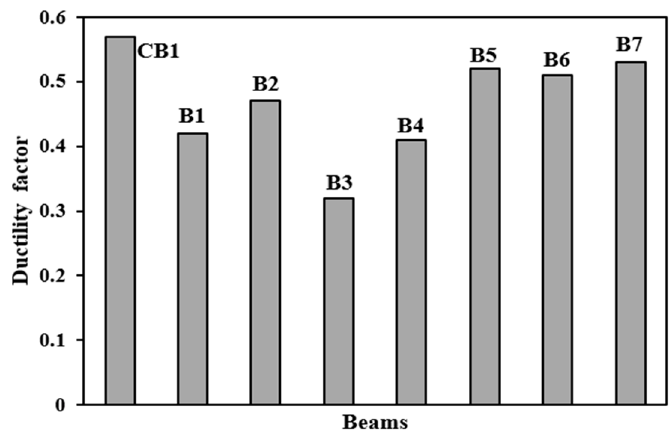
Figure 18. Ductility factors of control and retrofitted beams.